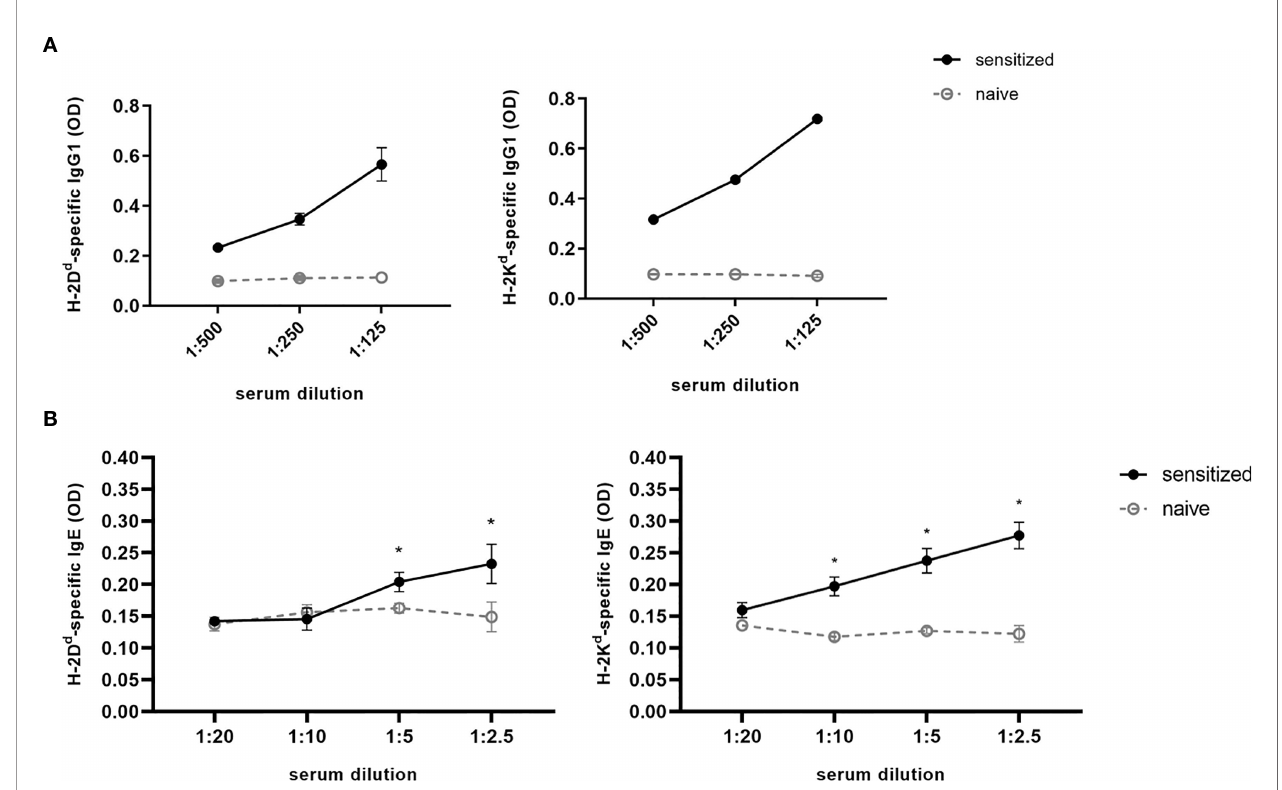
FIGURE 5 | Serum titration for detection of MHC-speci fi c IgG and IgE. For H-2D d - or H-2K d -speci fi c IgG 1 (A) or IgE (B) , a serial dilution of serum isolated from C57BL/6 mice sensitized with a BALB/c skin graft was performed. Serum dilution is ranging from 1:500 to 1:125 or from 1:20 to 1:2.5 for IgG 1 and IgE, respectively. As negative control naive C57BL/6 serum was used. Results from two independent experiments are shown for MHC-speci fi c IgE (n=4 for sensitized and naïve). P values were calculated using the Mann-Whitney U test *P < 0.05. Different dilutions of MHC-speci fi c IgG1 were shown in one experiment (n=2 for sensitized and naïve).